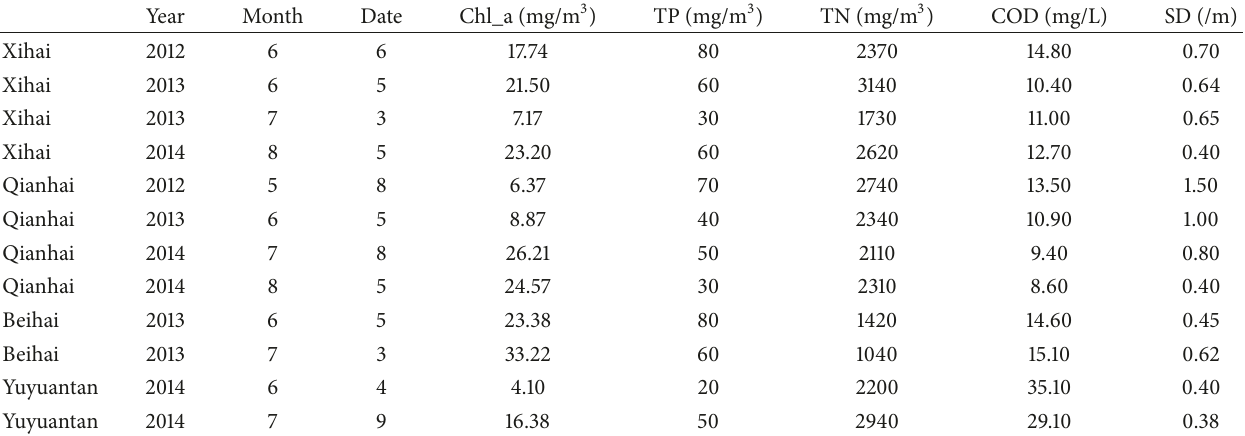
Table 7: Water quality information at quality monitoring points.